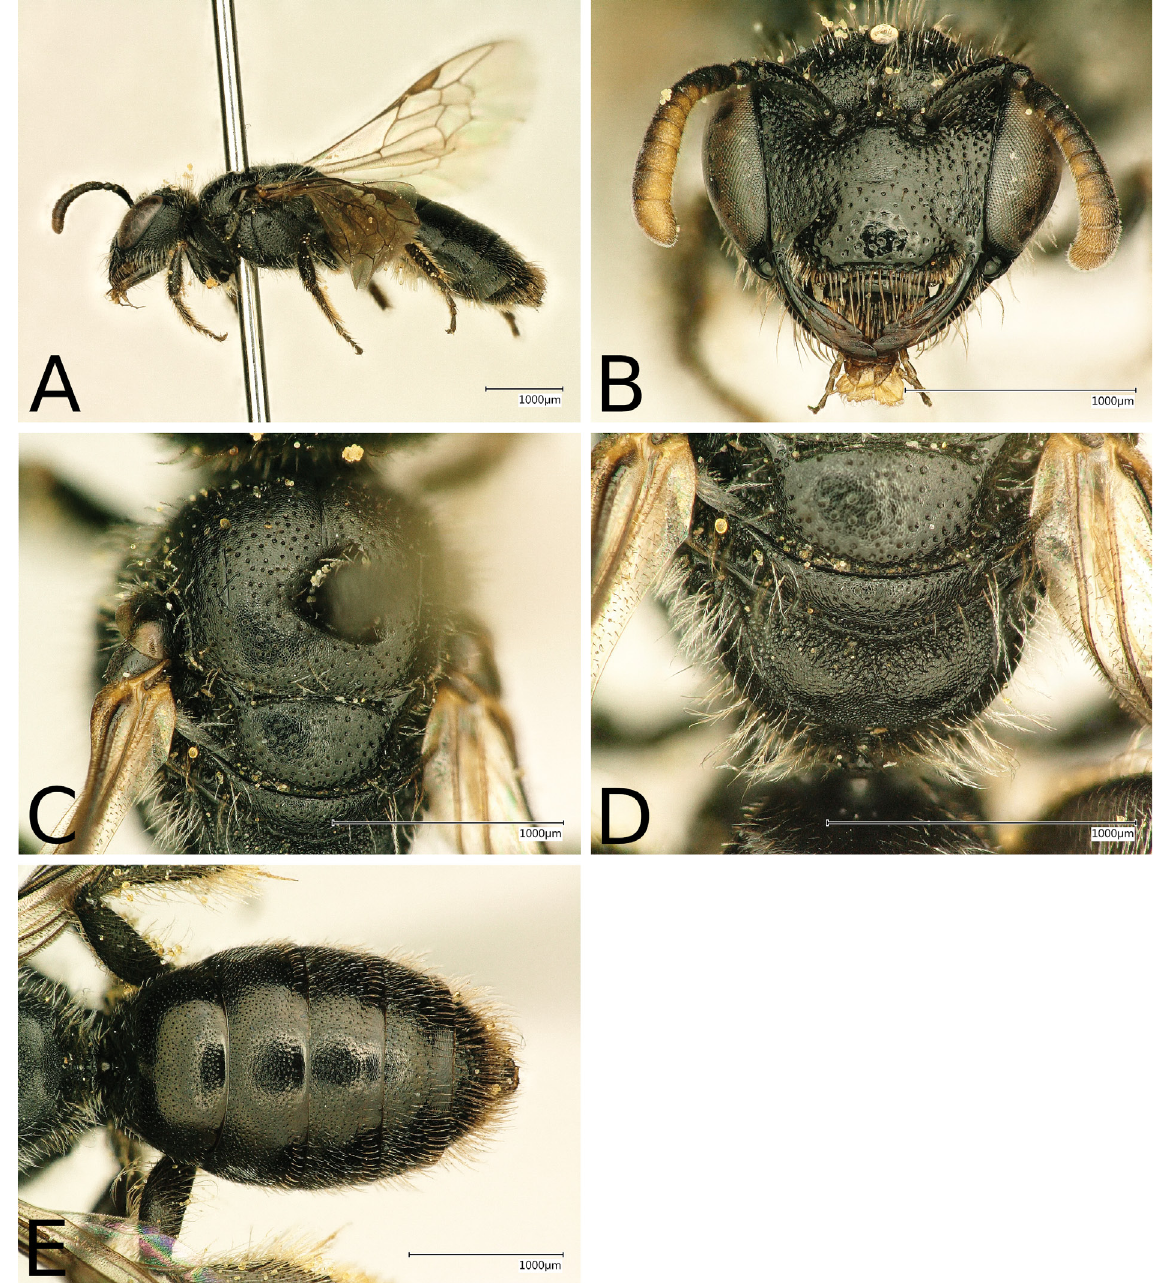
Fig. 1. Scrapter avontuurensis Kuhlmann sp. nov., ♀, holotype (RCMK). A . Lateral view. B . Head. C . Scutum and scutellum (dorsal view). D . Metanotum and propodeum (dorsal view). E . Metasoma (dorsal